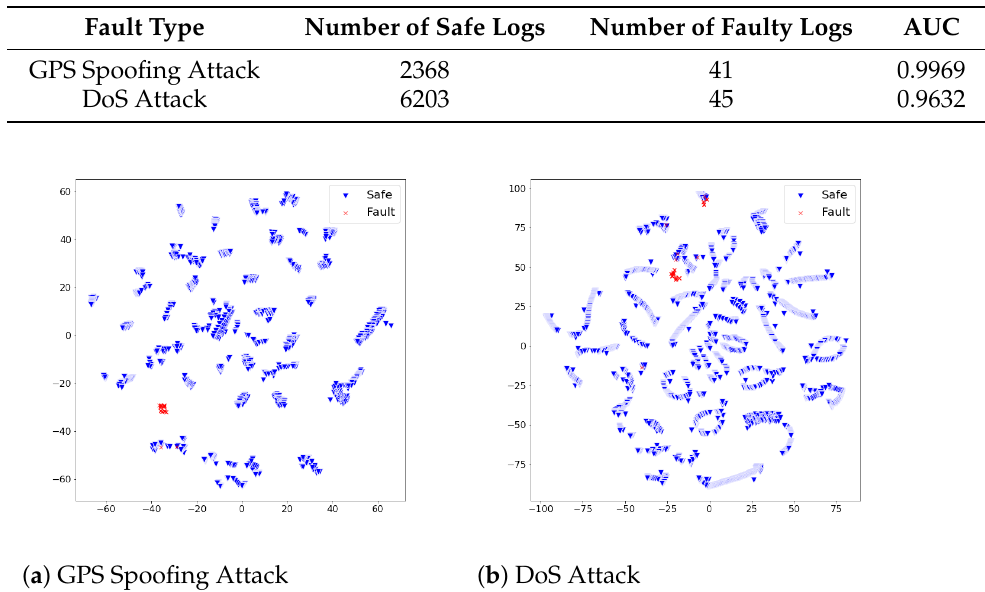
Figure 4. The distribution of dimensionality-reduced feature vectors from the safe states and faulty states vary on the two-dimensional (2D) space. The different distribution of both states implies the set of used features effectively describes each state’s pattern. We interpret this distinct distribution between safe states and faulty states empowered the autoencoder to effectively focus on patterns of safe UAV states; therefore, our approach could achieve precise fault detection performances in the UA dataset.